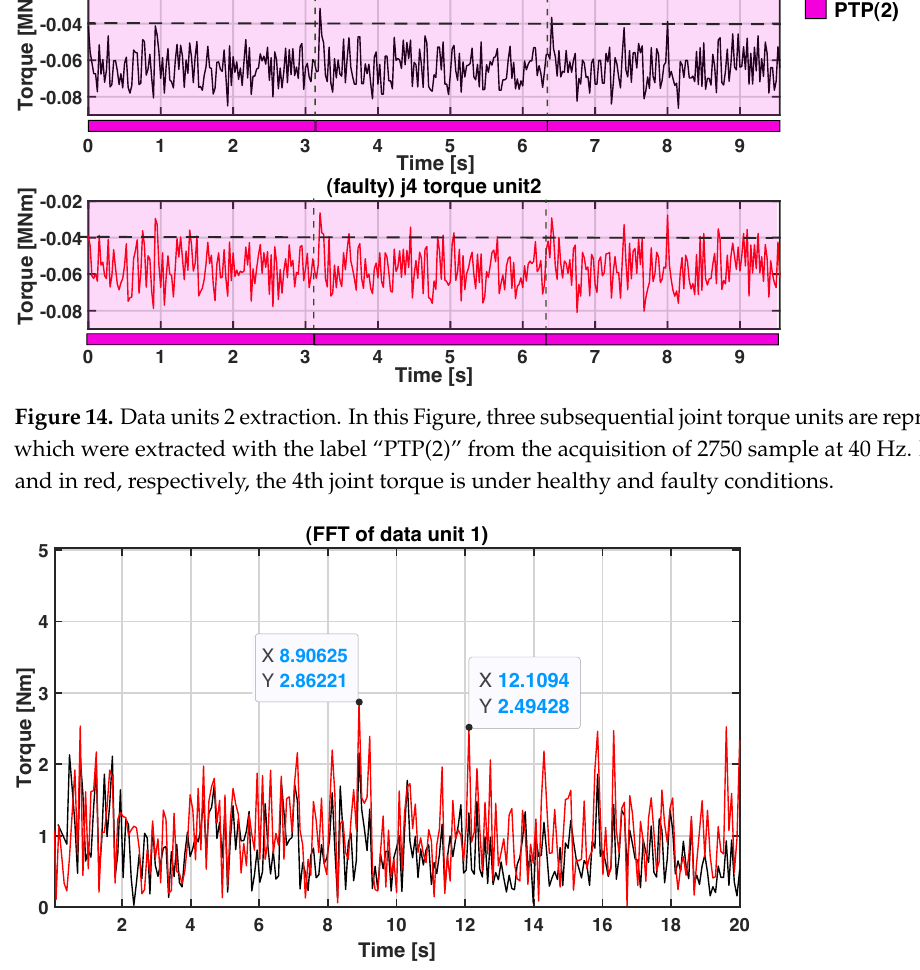
Figure 15. FFT applied to data unit 1 extraction. In black, the FFT of the joint torque under healthy conditions is represented, while in red, it is under in faulty